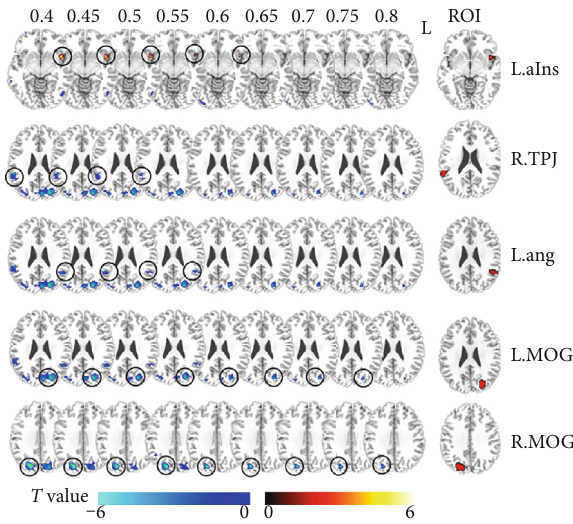
Figure 2: The di ff erences of global FCD maps between the euthymic PBD and HC groups in 9 Tc thresholds separately ( P < 0 : 005 , cluster size > 270mm 3 ). The left part shows 5 ROIs ’ position and designation; L: left. ROIs ’ abbreviations are consistent with those shown in Table